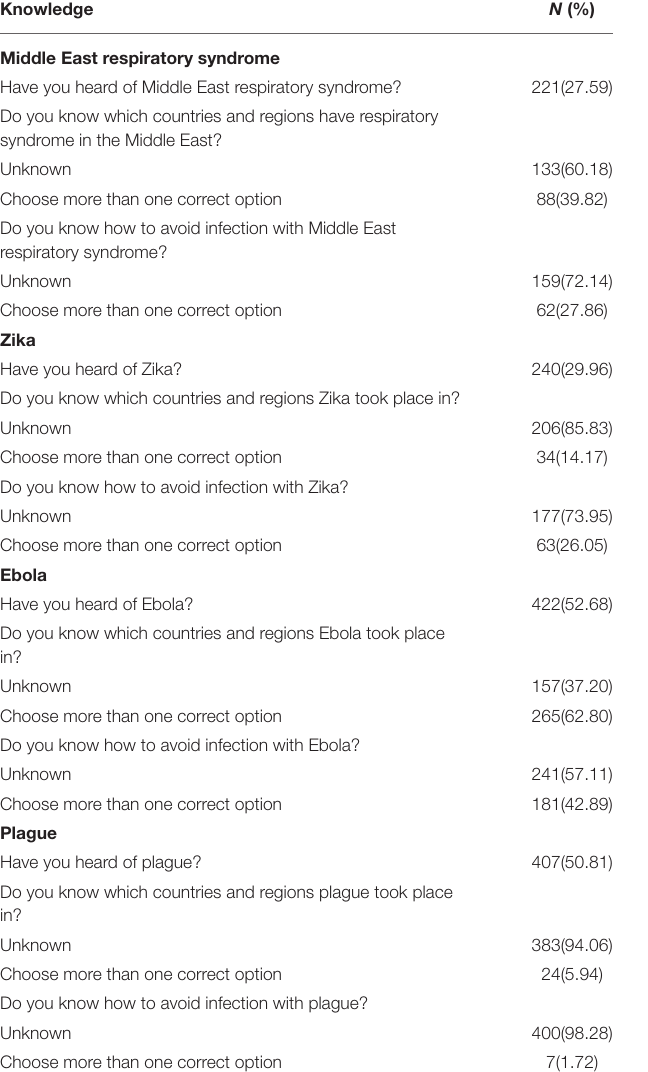
TABLE 3 | Factors associated with cognitive status of various diseases by multiple logistic